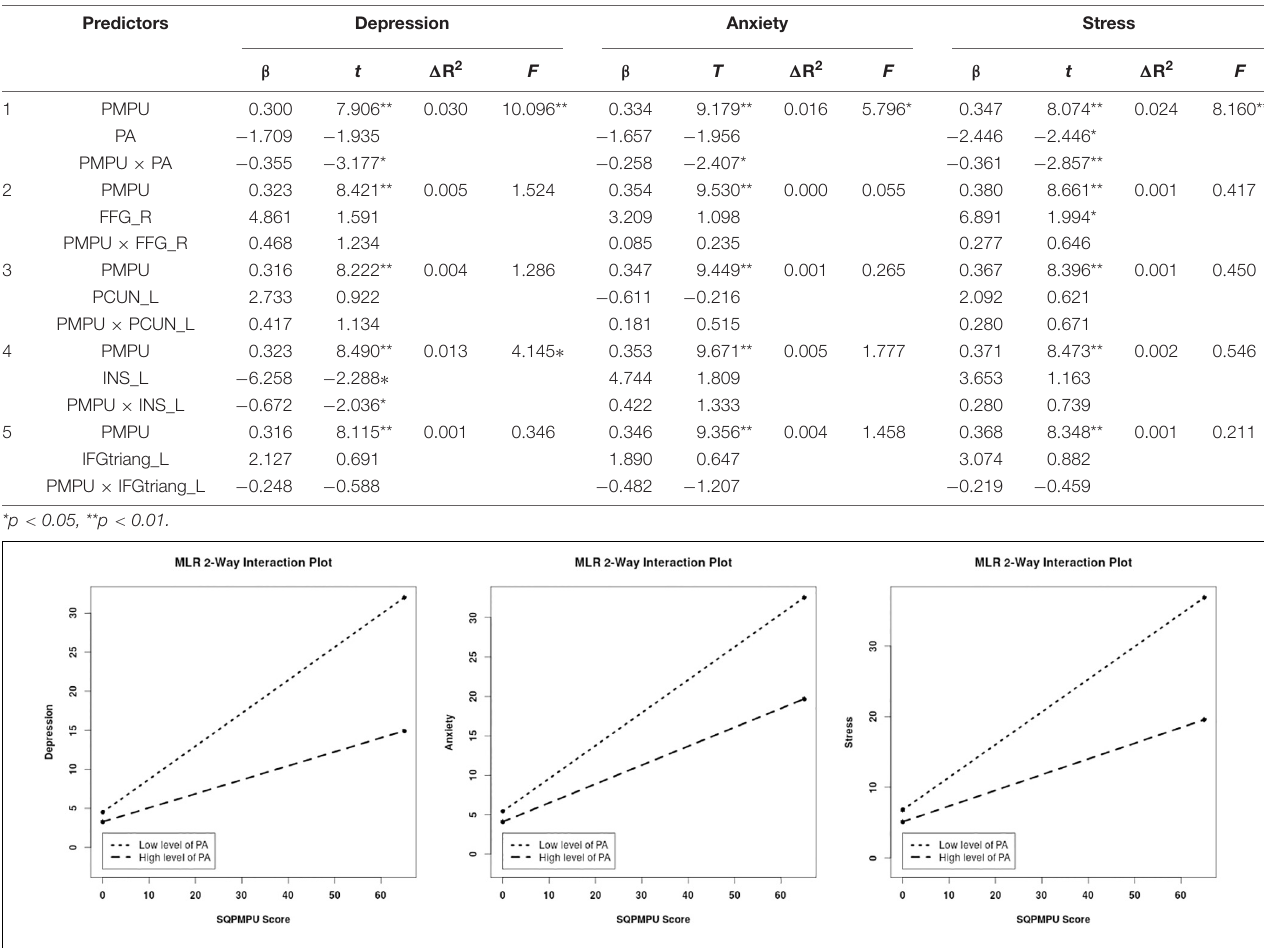
TABLE 3 | Results from the moderated regression analysis predicting psychological symptoms by adjusted age, gender, residential area, any siblings, perceived family income, academic performance, and educational level of parents. Predictors Depression Anxiety Stress